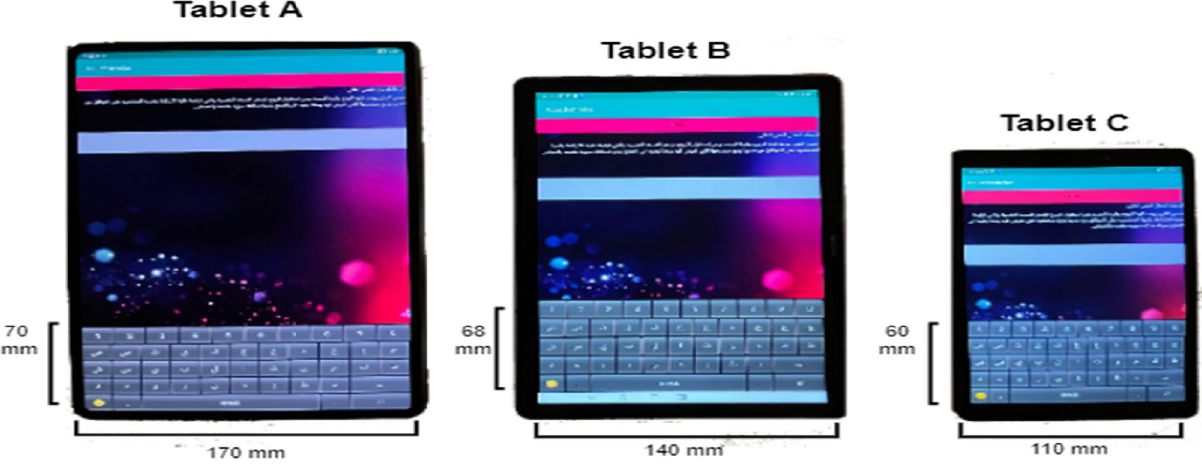
Figure 2. Each tablet’s keyboard